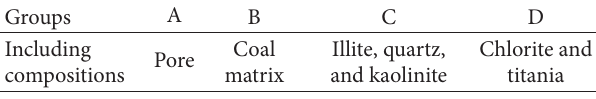
Table 1: Compositions groups of coal sample.